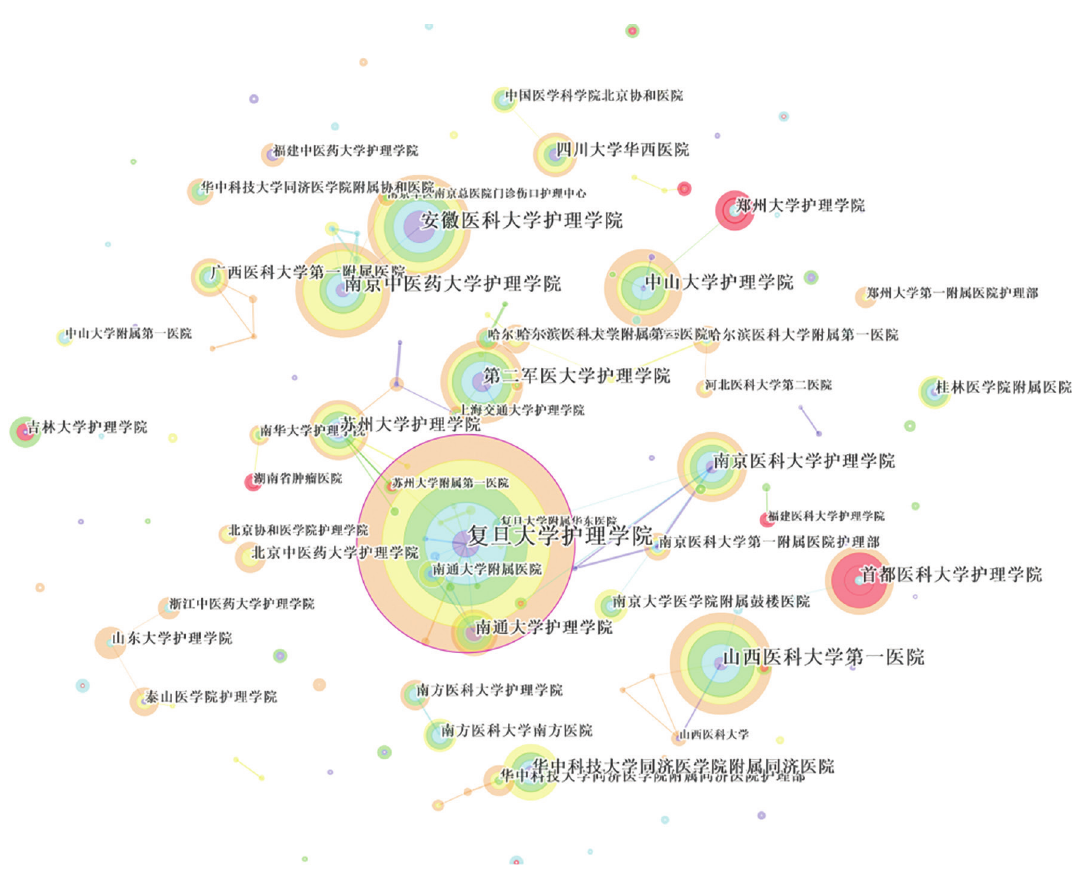
Figure 2. Mapping knowledge domains of collaborations among institutions.